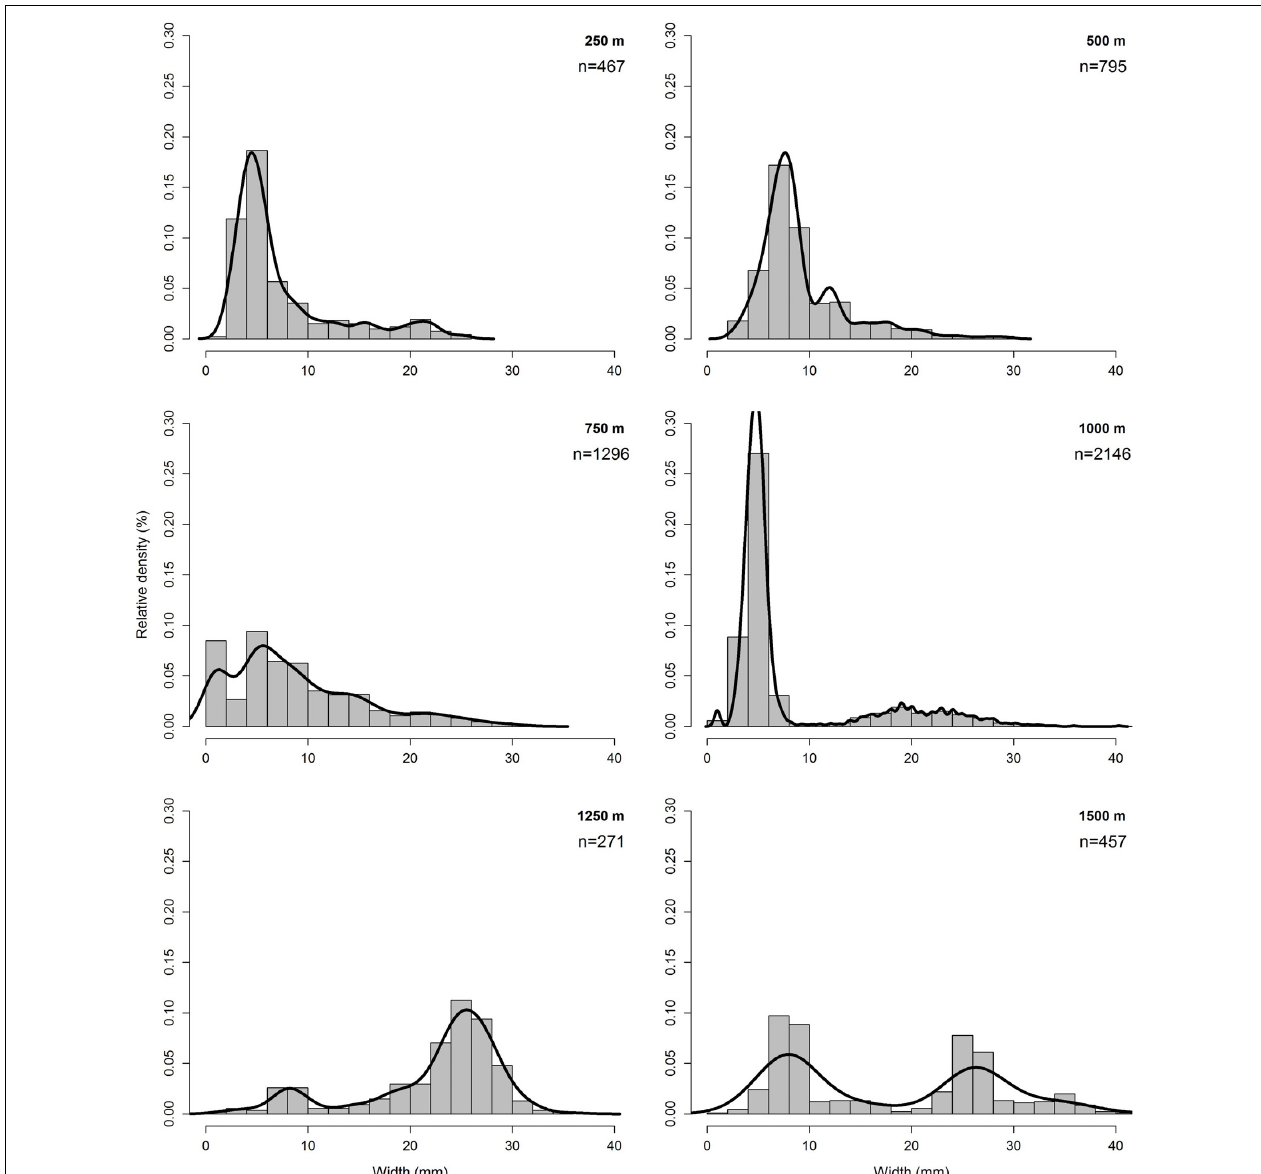
FIGURE 5 | Histogram of the relative density (%) of size classes per sampling distance.